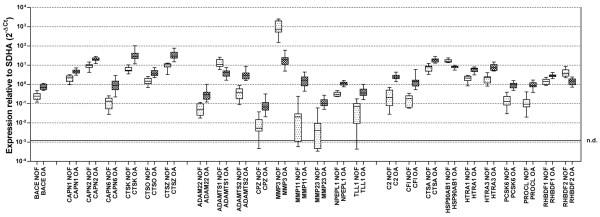
Genes showing most significant differential expression between osteoarthritis and fracture groups. Box and whisker plot for all genes displaying a statistical significance of P < 0.0001 by Mann-Whitney U test. For full gene names, see Tables 3 to 6. SDHA, succinate dehydrogenase subunit A; n.d., not detected.